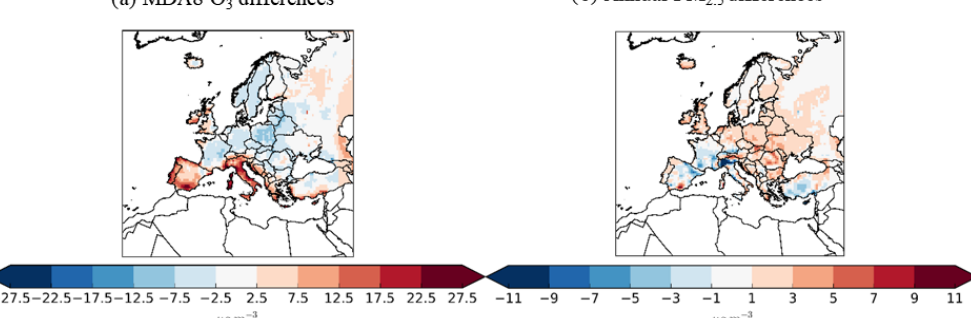
Figure 5. Differences in (a) warm season (April–September) mean of daily maximum 8h running mean O 3 (concentrations above 70µgm − 3 ) and (b) annual mean PM 2 . 5 between the coarse and finer resolution (coarse −